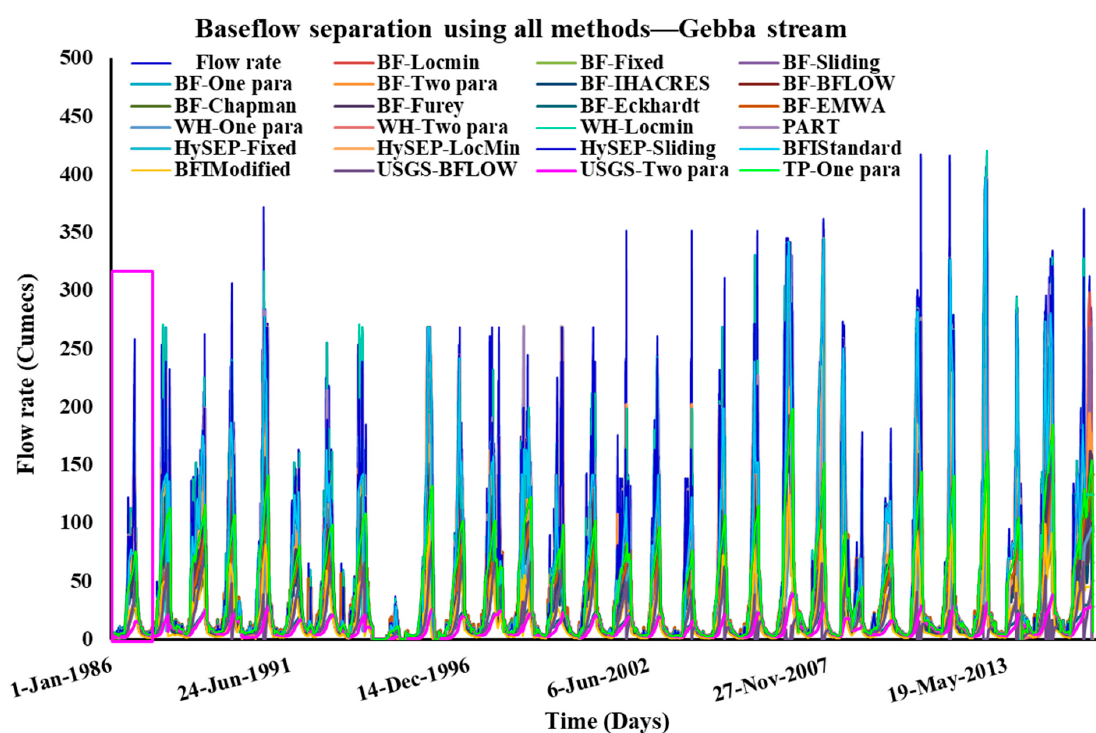
Figure 15. Baseflow separation results using all automated methods for the Gebba stream (all methods are drawn together. The figure is compacted and difficult to understand. Therefore, a detailed one-year baseflow separation result is displayed in Figure 16. The graph of each technique is shown in Figure 17).